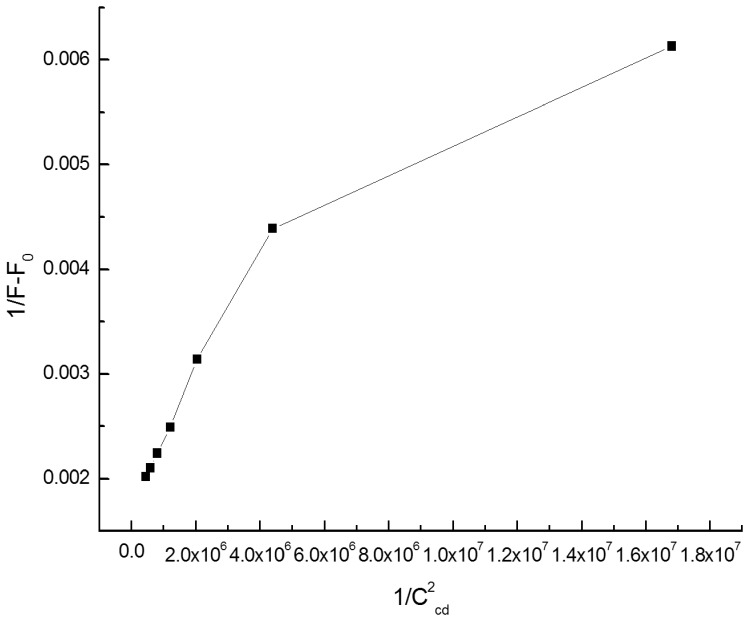
1/(F-F0)versus 1/Cβ-CD
2.